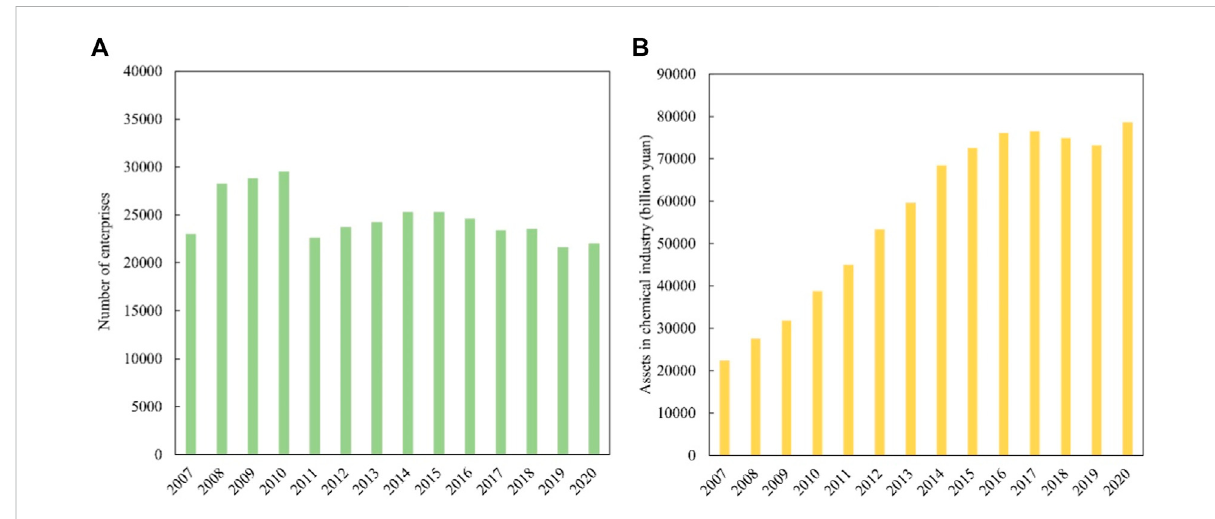
FIGURE 1 Number of enterprises (A) and total assets (B) in the chemical industry (Data source: China Statistical Yearbook).